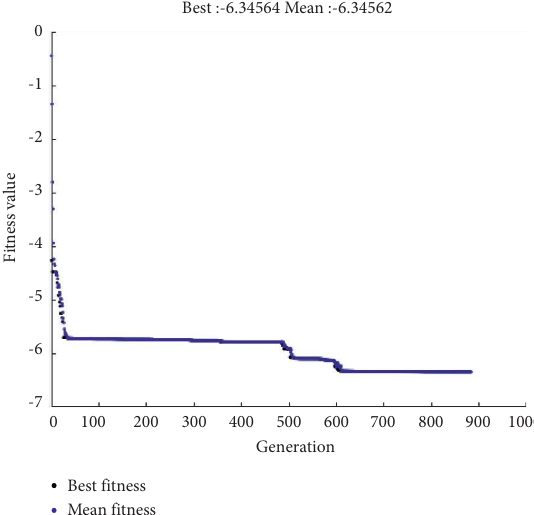
Figure 11: Algorithm iteration graph.